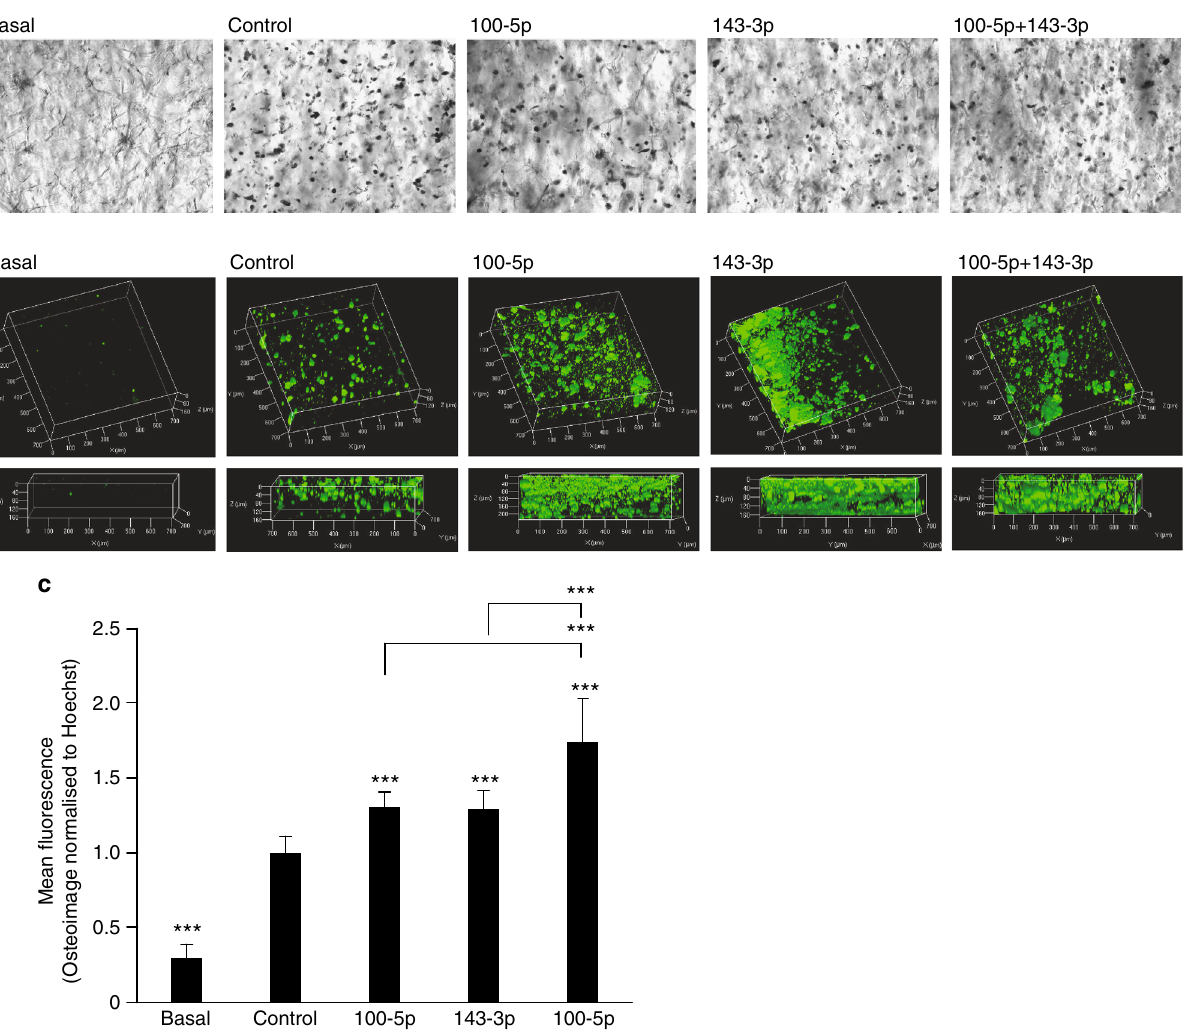
Fig. 6 miRNA modulation can enhance MSC differentiation in 3D hydrogels. a Phase contrast images of encapsulated hMSCs (black and white) on D14. Scale bar, 20 μ m. b 3D projections of hydroxyapatite staining (green) after 14 days encapsulation in 3D hydrogels. c Quantitation of hydroxyapatite levels. Data is shown as mean Osteoimage intensity relative to Hoechst intensity ± SD for N = 9 gels across 3 hMSC donors. Samples were analysed by one-way ANOVA with Tukey post hoc testing. Statistically different samples are denoted by * p < 0.05, ** p < 0.01 and *** p <